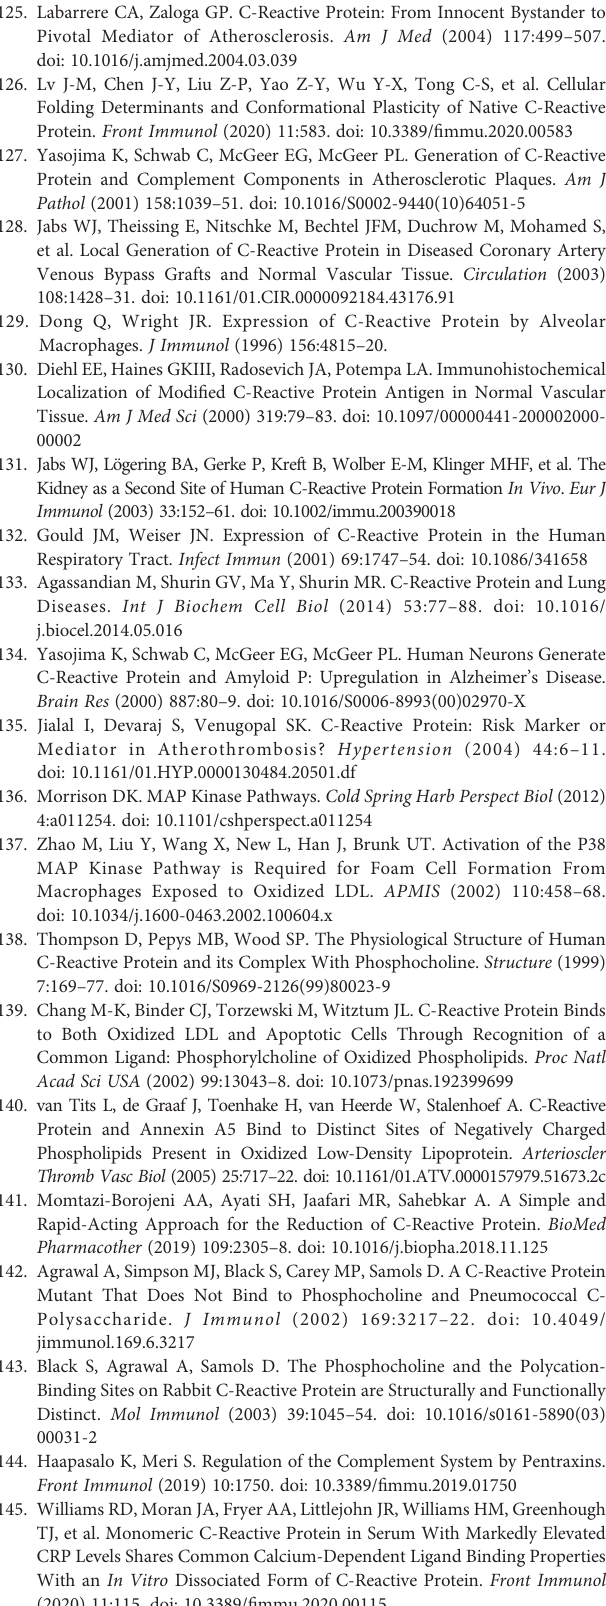
4:a011254. doi: 10.1101/cshperspect.a011254 137. Zhao M, Liu Y, Wang X, New L, Han J, Brunk UT. Activation of the